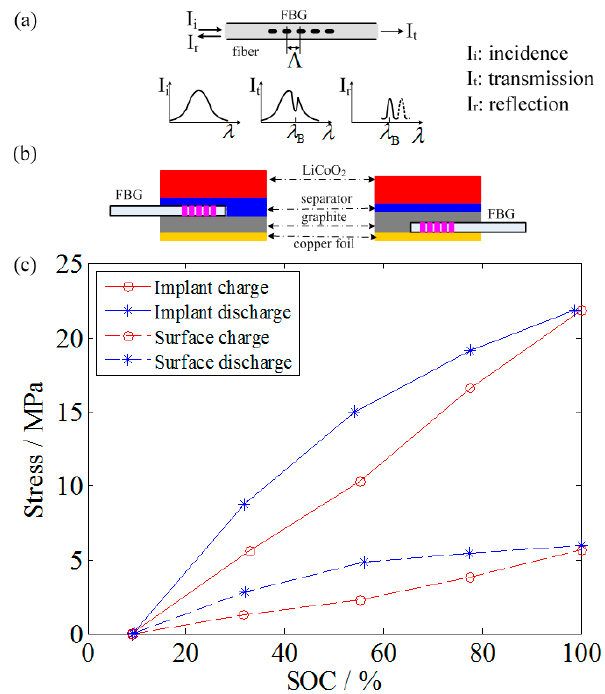
Figure 4. Responses of a fiber Bragg grating (FBG) sensor: ( a ) optical responses [44]; ( b ) location schematics of attached or implanted sensor [45]; and ( c ) in situ stress responses [45].